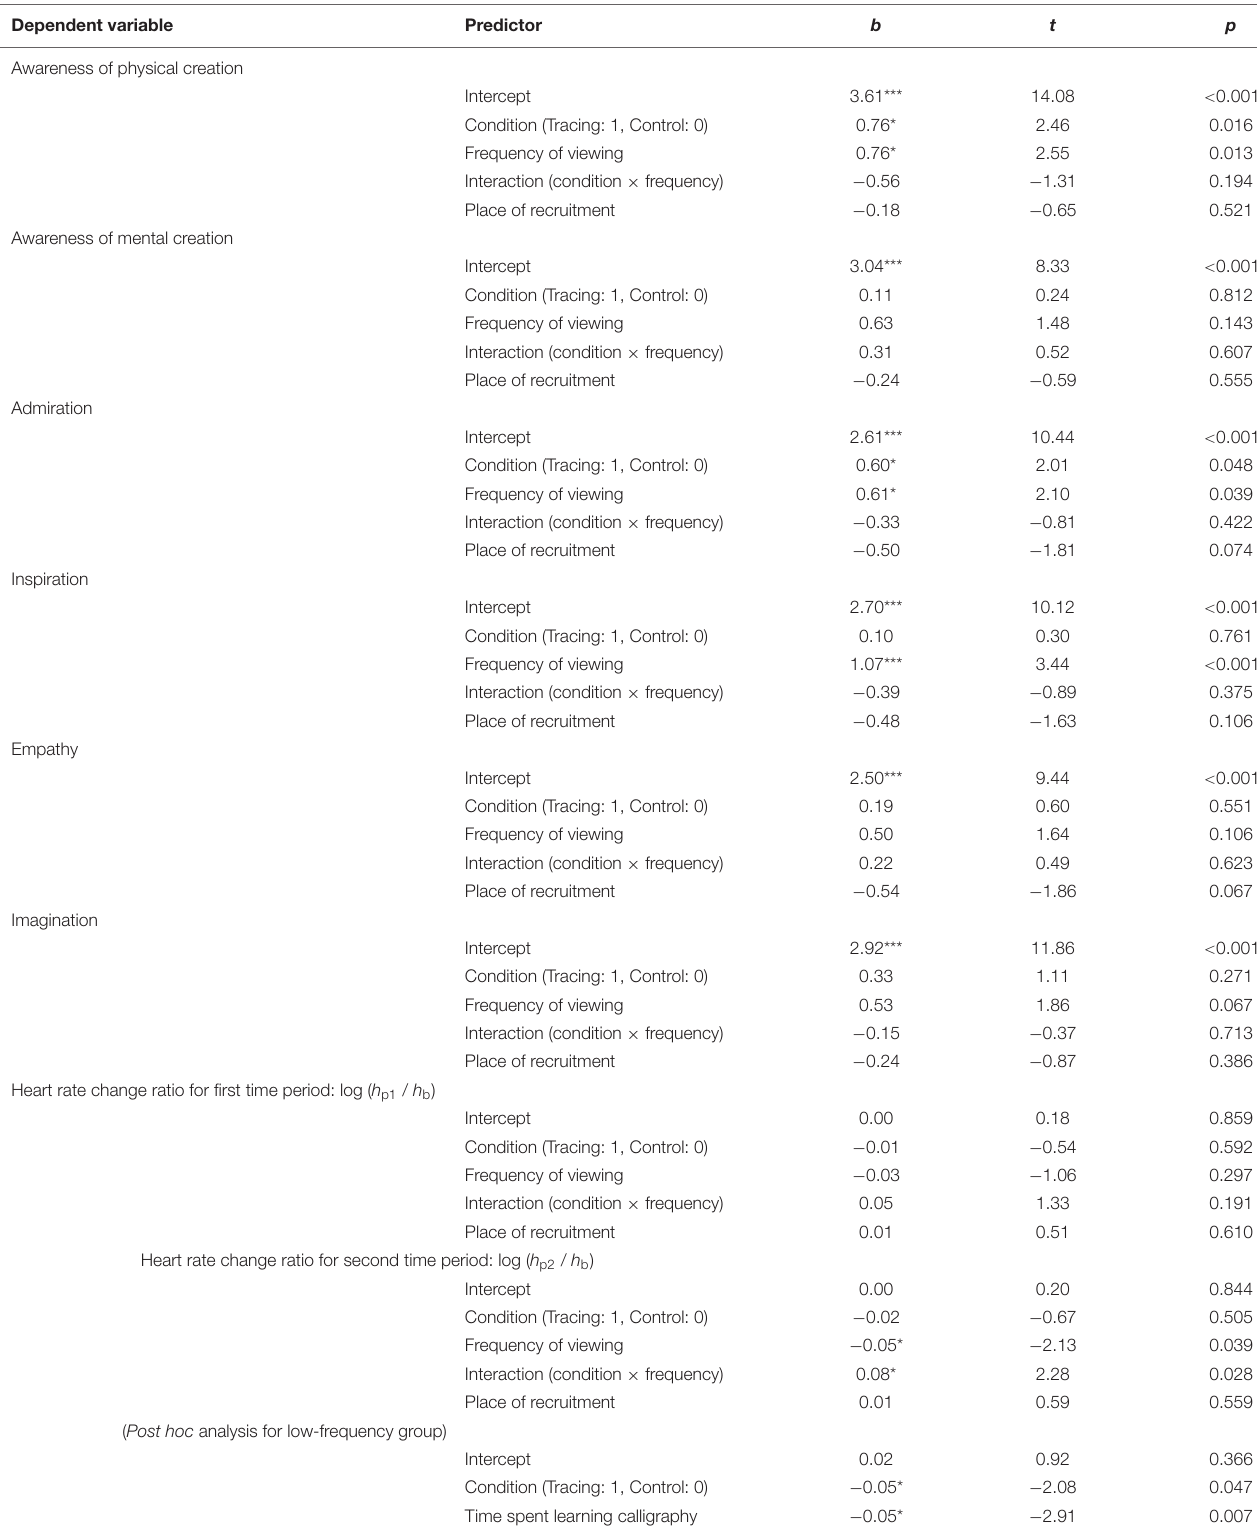
TABLE 4 | Multiple regression analyses in Study